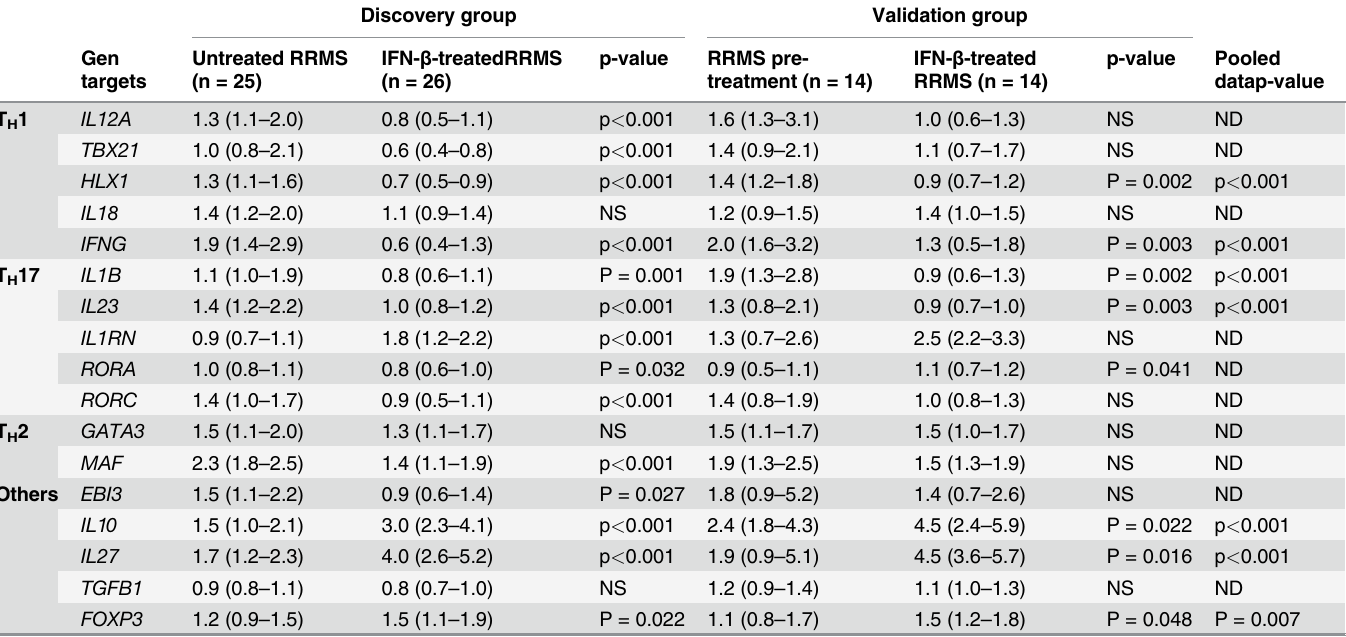
Table 4. Whole blood expression of genes associated with regulation, differentiation and activity of T-helper (T H ) and T-regulatory cells in untreated (UNT) and interferon (IFN)- β -treated patients with relapsing remitting multiple sclerosis (RRMS). Discovery group Validation group Gen